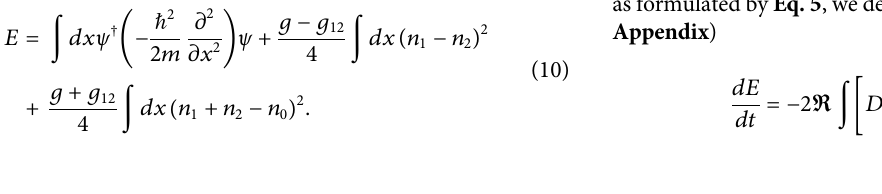
Frontiers in Physics |